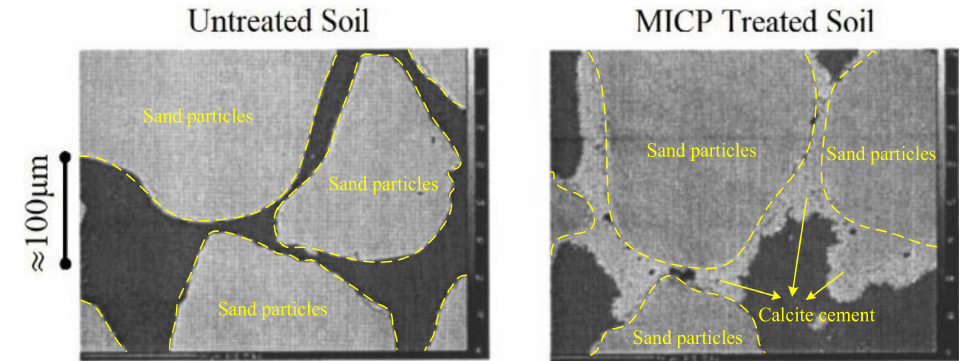
Figure 5. SEM graph of untreated and microbially induced calcite precipitation (MICP) treated soil [44].